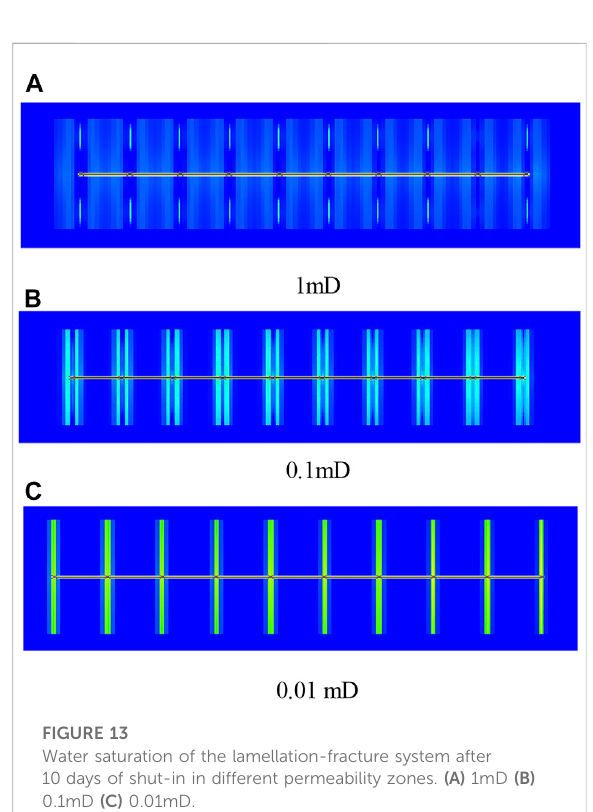
FIGURE 13 Water saturation of the lamellation-fracture system